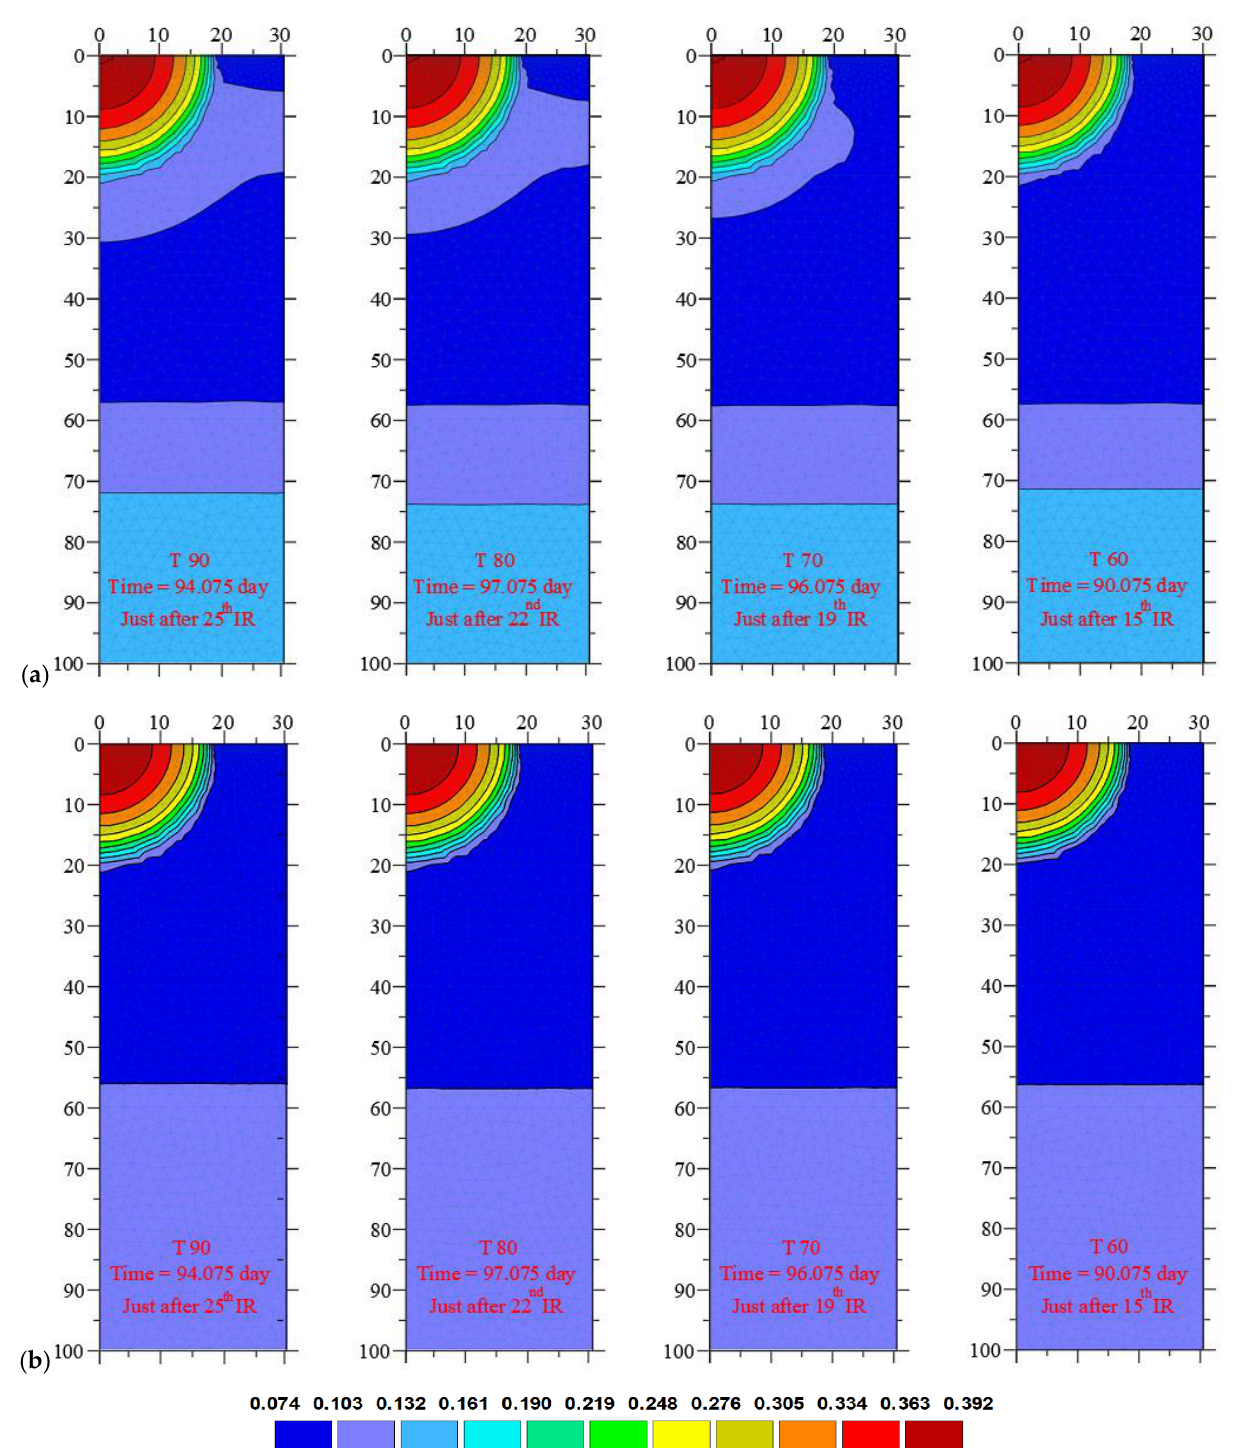
Figure 4. SWC distribution after the last irrigation event for the four irrigation treatments, ( a ) considering the root growth and ( b ) constant average root depth during the growing